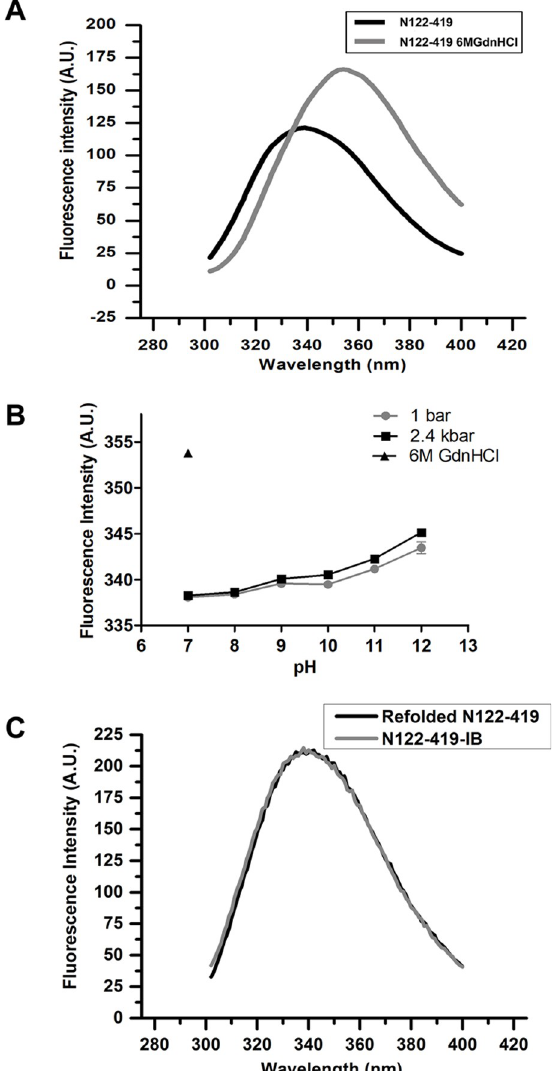
Fig 3. Compression at 2.4 kbar and alkaline pH induce only partial N122-419 unfolding. Suspensions of N122- 419-IB were subjected to 2.4 kbar for 90 min or to 1 bar for 4 h. A, Spectra of fluorescence of N122-419-IB at pH 7.0 and in the presence of 6M GdnHCl; B, λ maximum vs pH. Each condition was analyzed in triplicate. Values are expressed as mean ± SD. The results are representative of 2 independent assays; C, Spectra of fluorescence of refolded N122-419 and of N122-419-IB. The intensity of fluorescence of N122-419-IB was normalized to reach a value similar to the spectrum of refolded protein, for a better